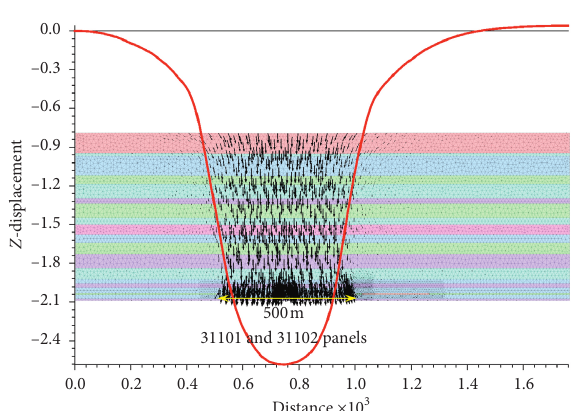
Figure 18: Subsidence of 31101 and 31102